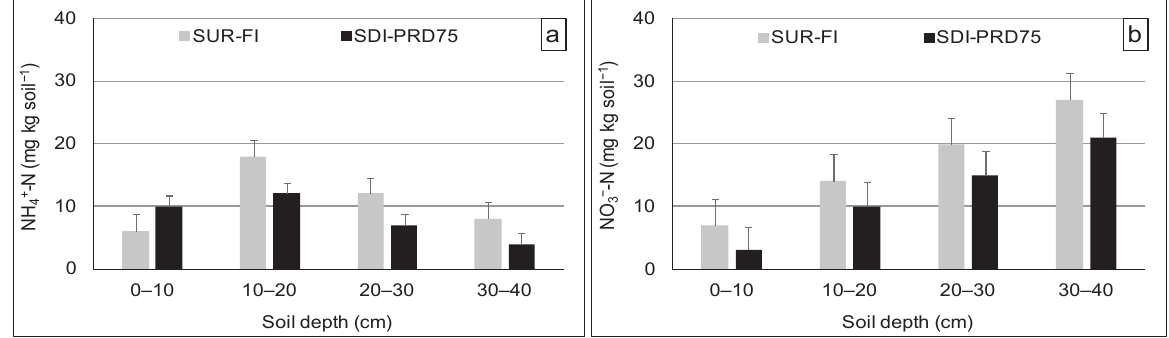
Fig. 5: Soil residual NH 4 + -N (a) and NO 3 – -N (b) contents at different soil depths for SUR with FI and SDI with (PRD 75 ) at the last harvest of tomato in 2016. Error bars indicate standard error of the means ( n = 3) ± S.E. FI = full irrigation; PRD = partial root zone drying; SDI = subsurface drip irrigation; SUR = surface drip